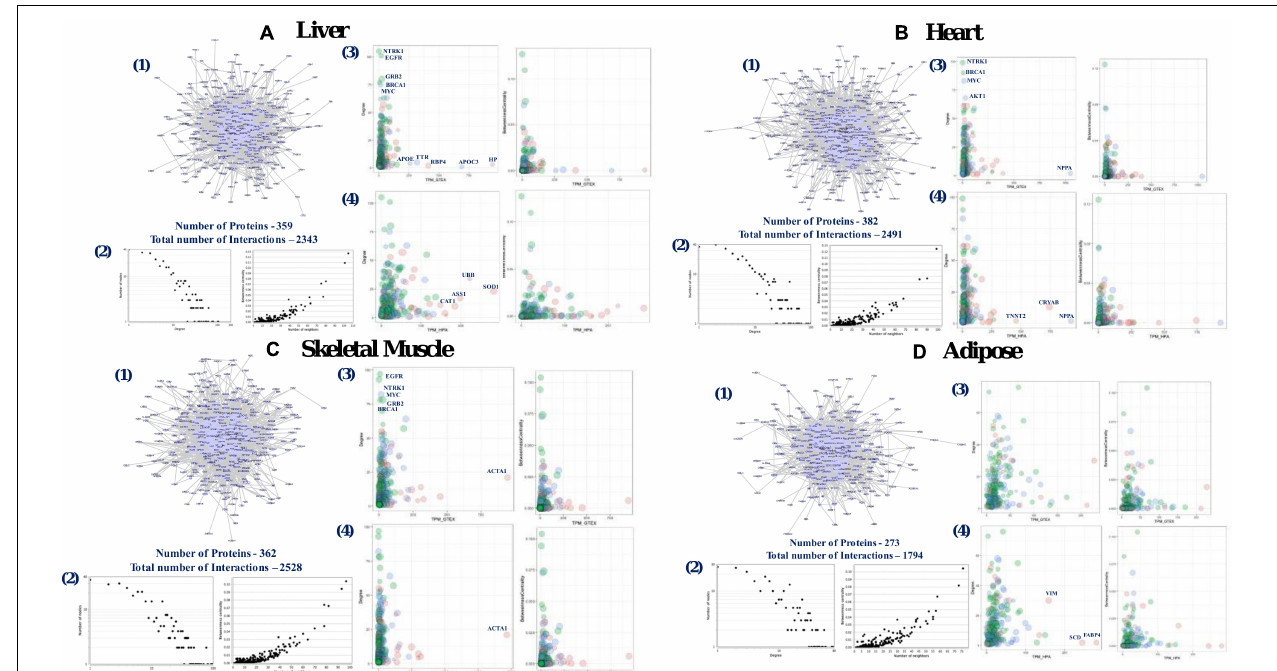
FIGURE 5 | Tissue specific local-PPIN of human aging and longevity related genes. Tissue specific local-PPIN was constructed based on protein level expression information for aging and longevity related genes in human: (A) liver, (B) heart, (C) skeletal muscle, and (D) adipose tissues. [1] The network graphs indicate the number of proteins expressed in each tissue and their interactions. [2] The degree and betweenness centrality distribution plots for tissue specific local-PPINs. [3] Comparison of transcripts and protein level expression values of genes present in tissue specific local-PPIN based on Genotype-Tissue Expression (GTEx) data. [4] Comparison of transcripts and protein level expression values of genes present in tissue specific self-PPIN based on The Human Protein Atlas (HPA) data. The node size represents the Convergent Orthologs Score (COS) of genes calculated based on cross-species orthologs statistics in 57 different species from OrthoDB database. The node color represents the protein level expression values of genes in respective tissues.